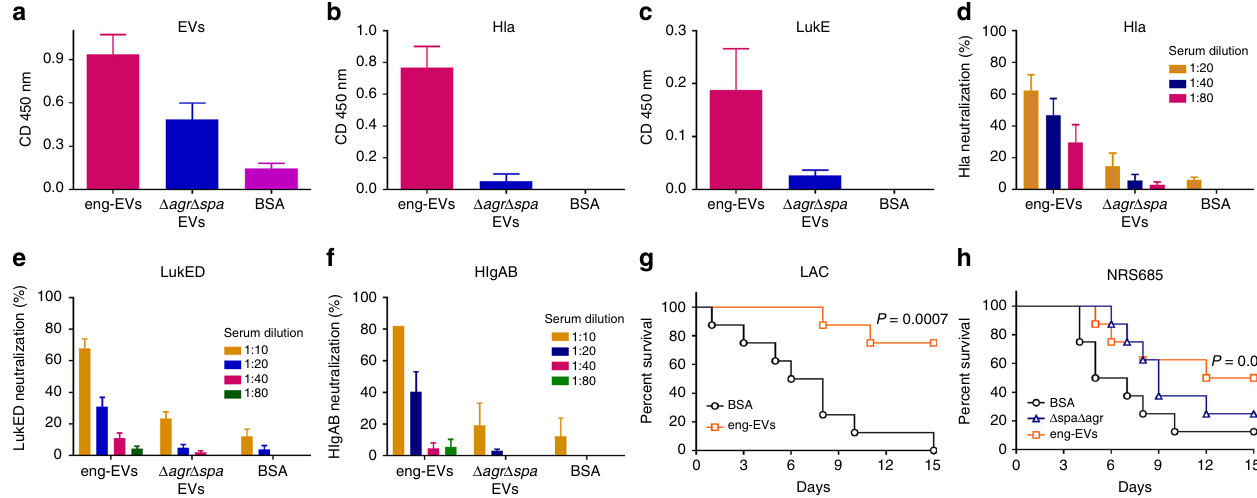
Fig. 6 Immunogenicity and protective ef fi cacy in mice of engineered-EVs. Antibody levels in sera (diluted 1:100) from mice immunized with eng-EVs were analyzed on ELISA plates coated with a JE2 sonicated EVs, b Hla, or c LukE. Data were expressed as mean ± s.e.m. The neutralizing activity of sera from mice immunized with BSA or different EV preparations was determined by either incubating serial dilutions of sera with d Hla, e LukED, or f , or HlgAB for 1 h at 37 °C before adding target cells. Control cells were incubated with toxins but no sera. Data are expressed as percent neutralization ± s.e.m. Mice ( n = 8) immunized with different JE2 EV preparations were challenged IV with 8 × 10 7 CFU S. aureus LAC ( g ) or 2 × 10 8 NRS685 ( h ). Survival